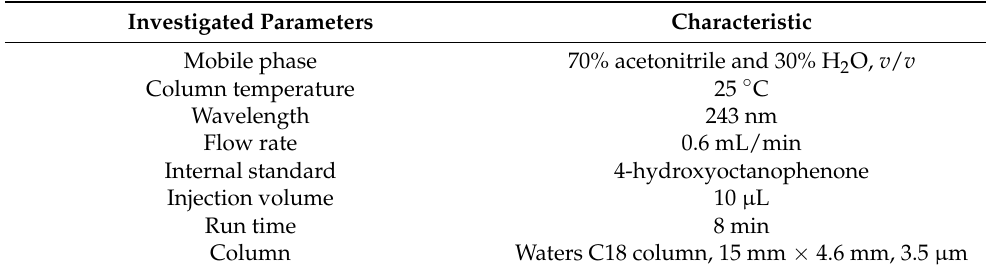
Figure 2. HPLC chromatogram displaying CYP3A2 assay components: ibuprofen (tR: 2.098), 6 β -hydroxydexamethasone (tR: 2.567), dexamethasone (tR: 3.079) and 4 − hydroxyoctanophenone (IS) (tR: 6.650) separation. Table 1. Displaying HPLC investigated